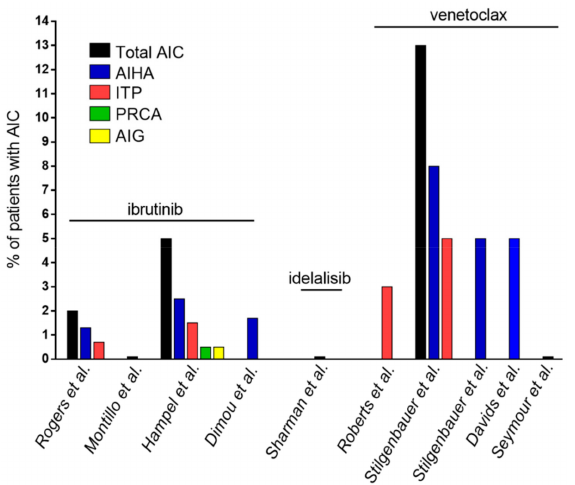
Figure 2. Occurrence of autoimmune cytopenias in patients with CLL treated with targeted